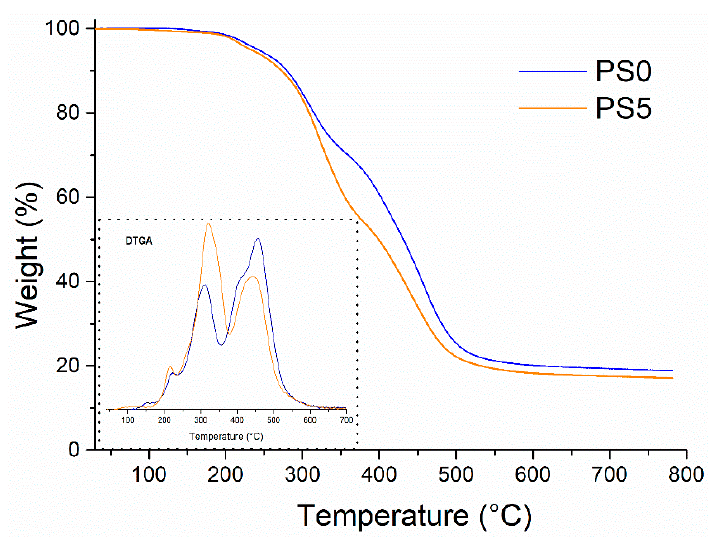
Figure 9. TGA and DTGA of selected produced bio ‐ based foams, PS0 and PS5.